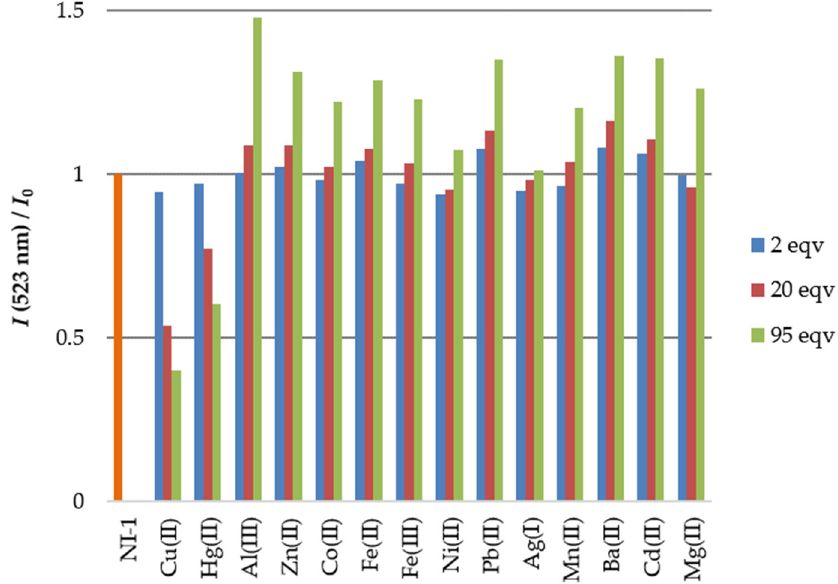
Figure 5. Change of fluorescence intensity at 523 nm for NI-1 (orange) and in the presence of metal ions in MeOH/buffer (v/v, 1/2, pH = 5.5) solution.